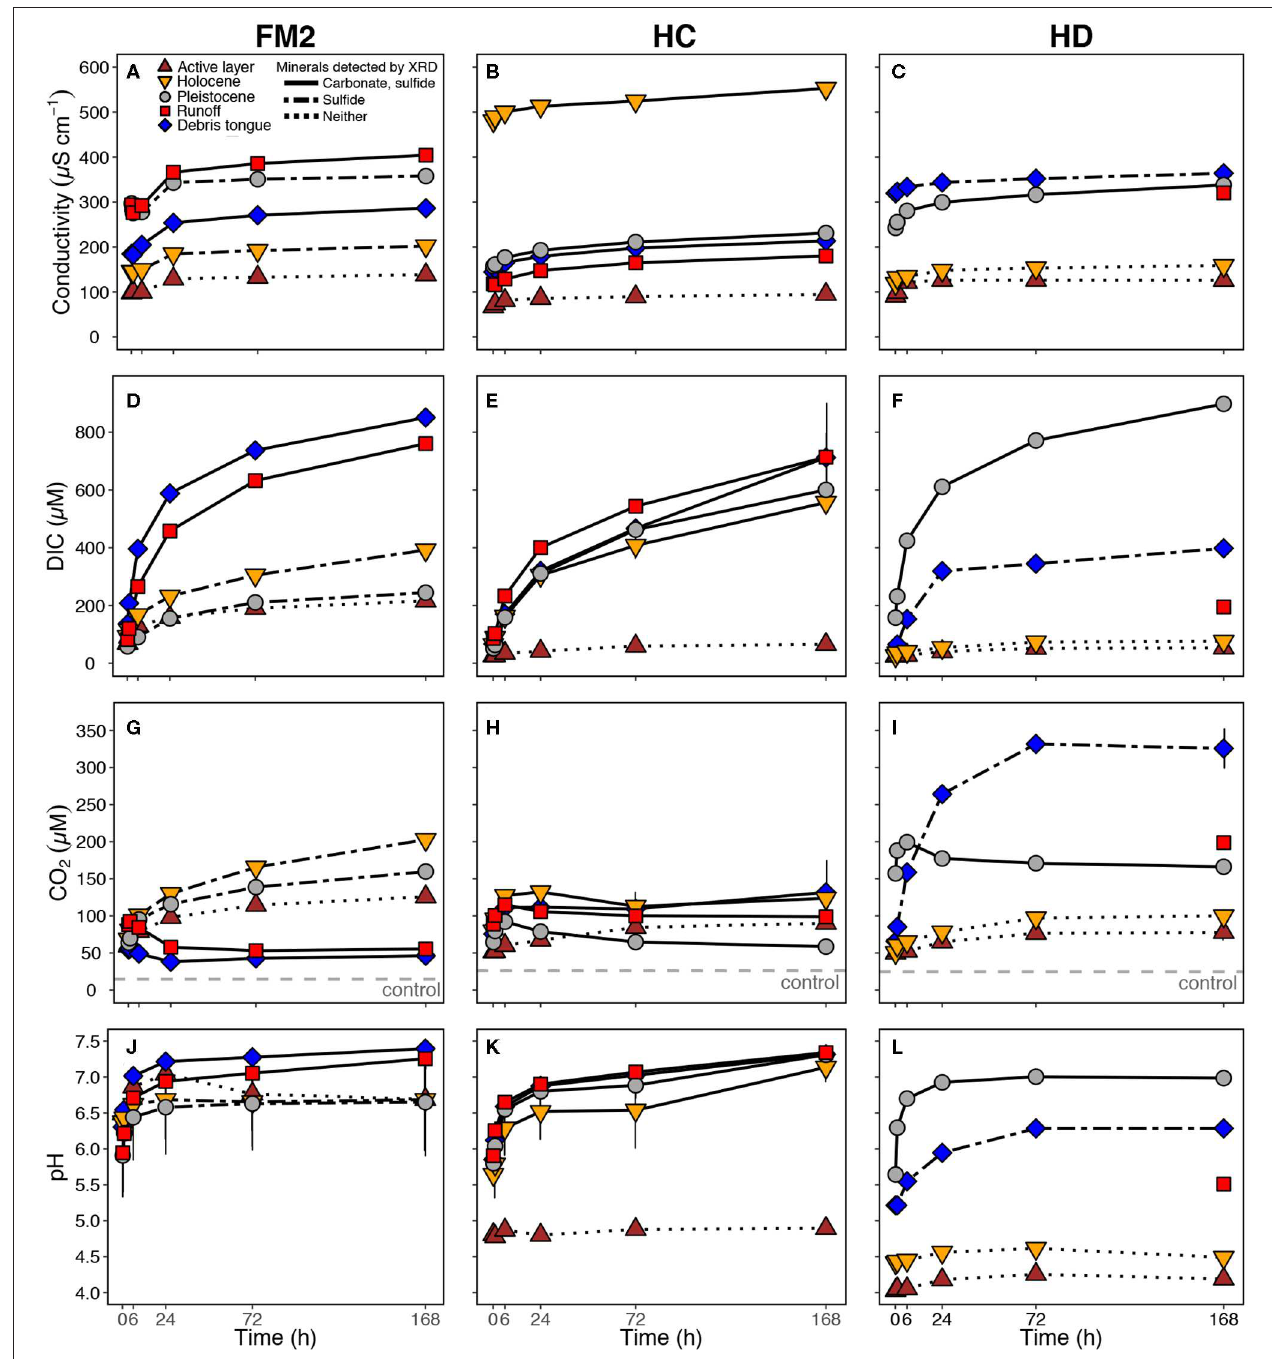
FIGURE 3 | Weathering experiment trends in (A-C) conductivity, (D-F) dissolved inorganic carbon (DIC), (G-I) dissolved CO2, and (J-L) pH by RTS and sediment source. Error bars represent ± standard deviation for conductivity, DIC, and CO 2 , and range for pH (bars do not appear where smaller than symbol). See Figure 1 for locations and Table 1 for site characteristics. (G–I) Dashed lines represent CO 2 concentration in control bottles.